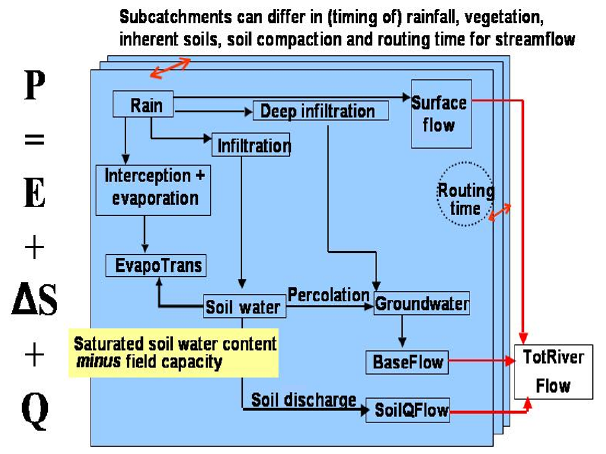
Figure B1. Overview of the GenRiver